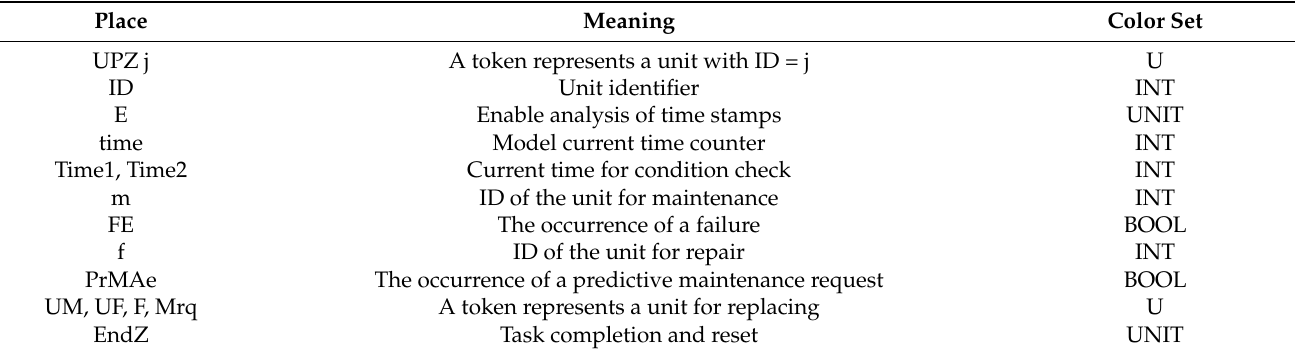
Table A2. Places of Unit ID modules.